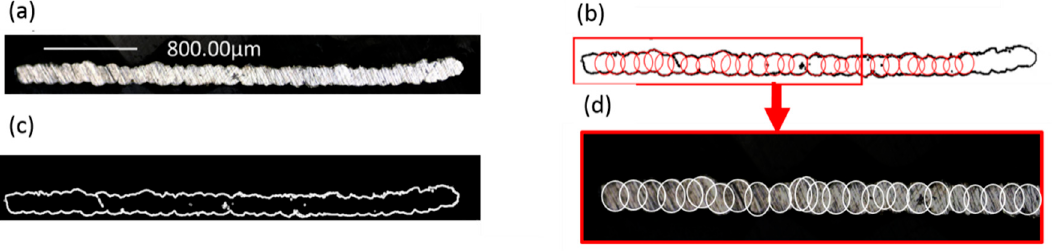
Figure 4. The methodology used for the analysis of thin walls: ( a ) image obtained through the infinite focus microscope; ( b ) extraction of the thin wall contour; ( c ) approximation of the ellipses to the generated contour; ( d ) checking this approximation in the obtained image.